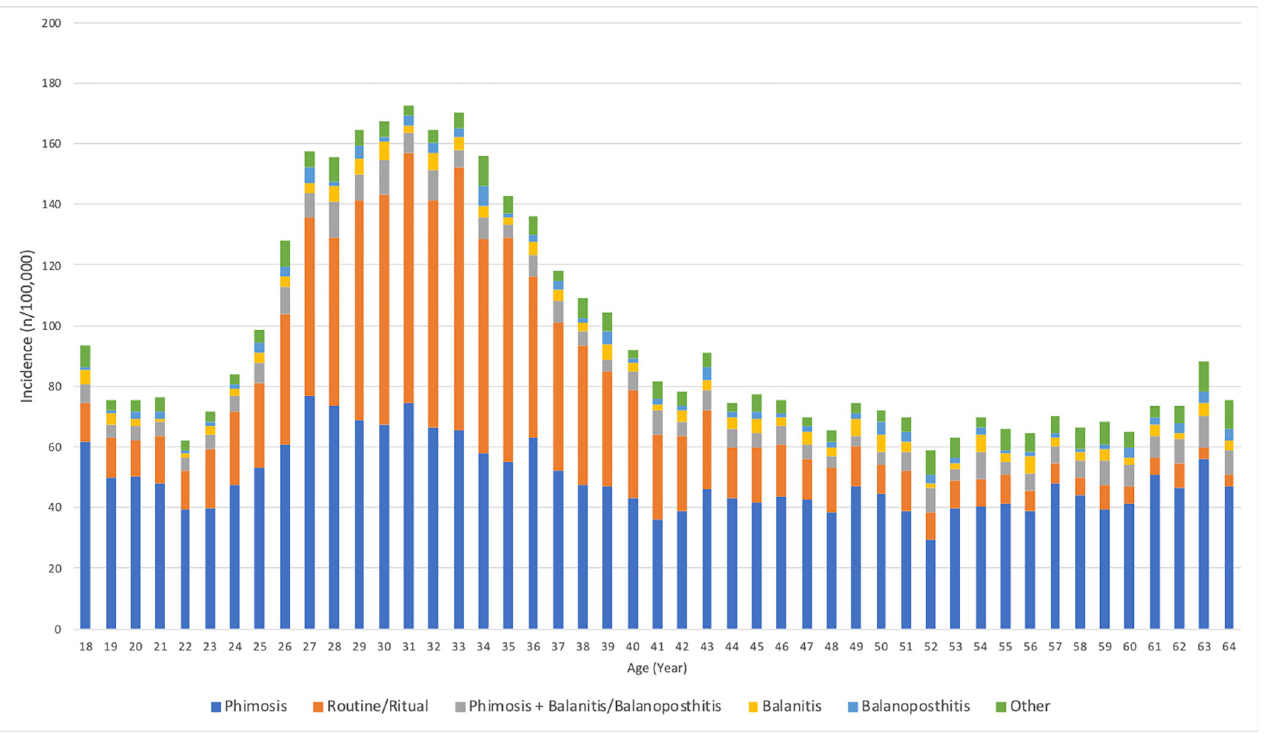
Fig 1. Incidence of adult circumcision across the age range defined by indications.